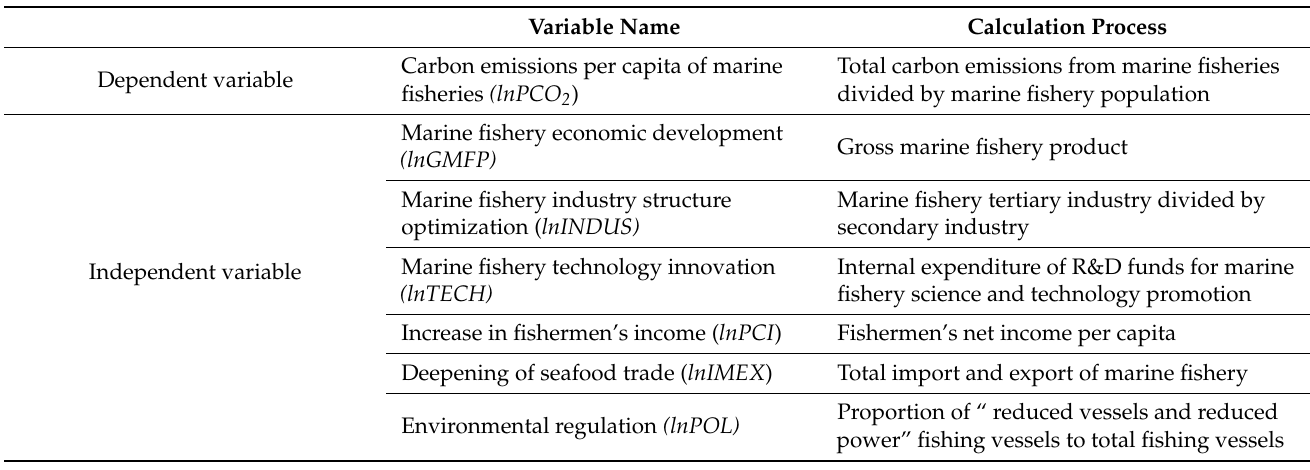
Table 2. Explanation of